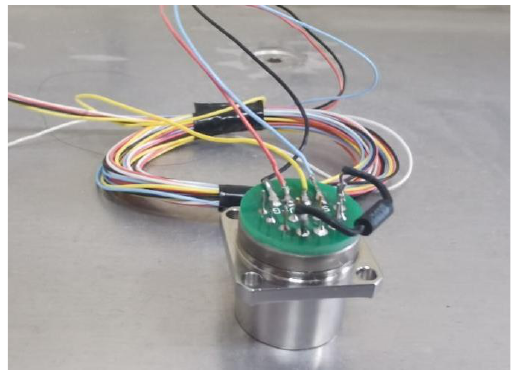
Figure 4. Flow chart of mixed signal separation process based on SSA and FastICA.